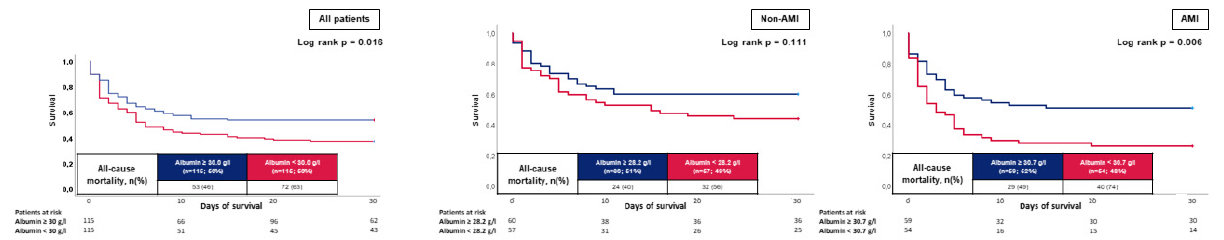
Figure 3. Prognostic impact of albumin on day 1 on the risk of all-cause mortality at 30 days within the entire study cohort (left panel), as well as strati fi ed by patients with AMI-related CS (middle panel) and non-AMI-related CS (right panel). Table 5. Uni- and multivariable Cox regression analyses with regard to 30-day all-cause mortality within the entire study cohort. Variables